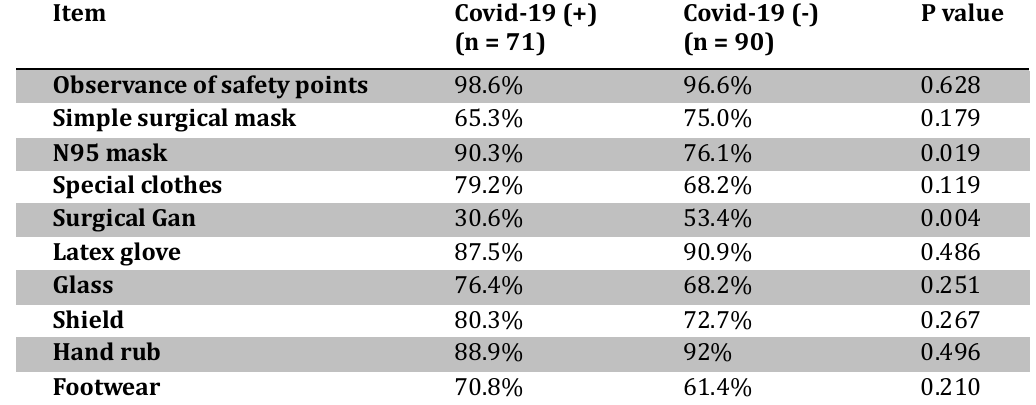
Table 2: Personal protective equipment among personnel with and without Covid-19